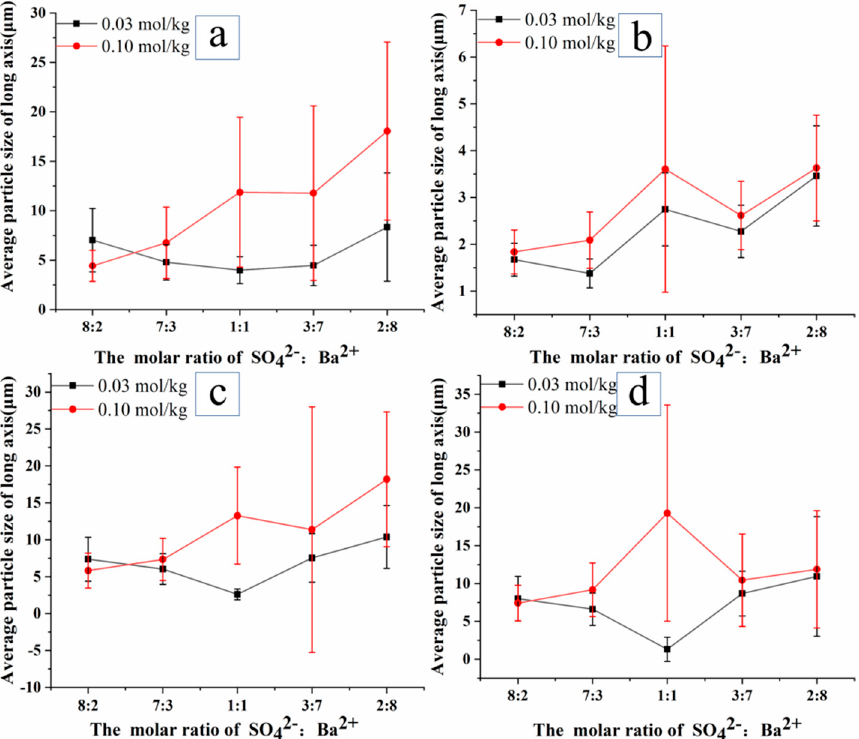
Figure 8. Average particle size of barite synthesized with different initial concentration solution and mixing ratio at 200 °C. ( a ) rod-shaped ( b ) granular ( c ) T-shaped ( d )